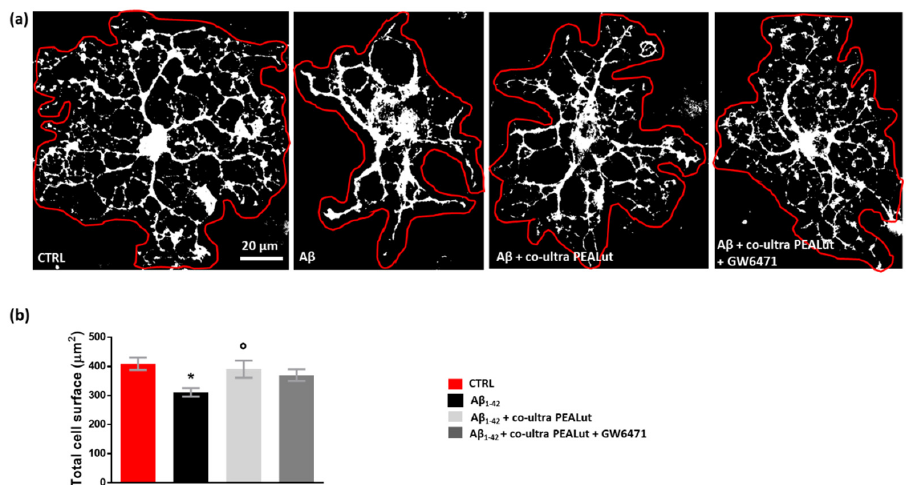
Figure 5. Co-ultra PEALut prevents oligodendrocyte shrinkage caused by A β 1–42 . ( a ) Representative thresholded (white color) photomicrographs of MBP + cells taken under a 40× objective mounted on a fluorescent microscope. Scale bar is 20 μ m. ( b ) Quantification of total MBP + cell surface area expressed in μ m 2 . Cell contours were manually drawn using Fiji. Data are plotted as mean ± SEM. * p < 0.05 vs. CTRL; ° p < 0.05 vs. A β (SNK test).